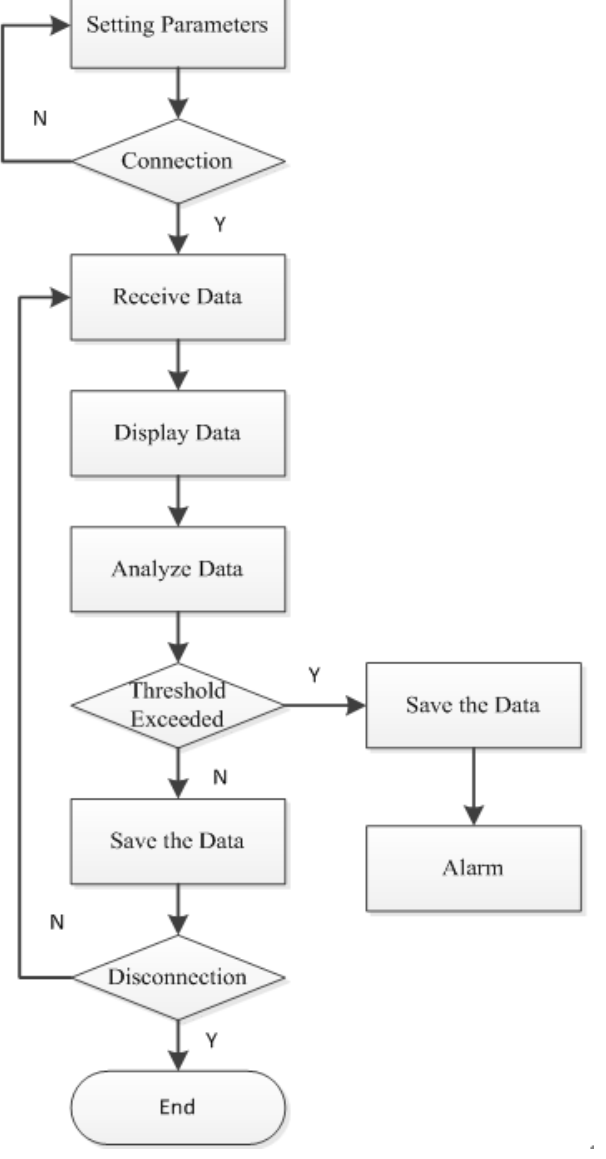
Figure 7. Software Figure 7. Software workflow.